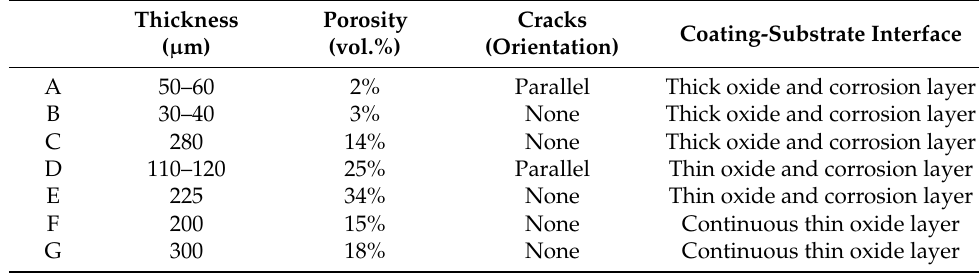
Table 5. Summary of the coating microstructural features of the enamel coatings on low-alloyed 16Mo3 boiler steel after the oxidation at 650 ◦ C for 48 h in wet Ar (the vol.% of porosity is based on image analyses of the cross-sections and should be considered as comparative values). Significant changes compared with the coatings in as-deposited conditions (Table 2) are highlighted using italic